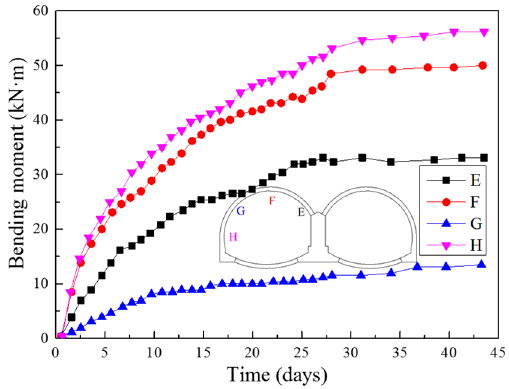
Figure 22. Time history plots of the absolute values of the bending moments in secondary linings in the K89+729 section.